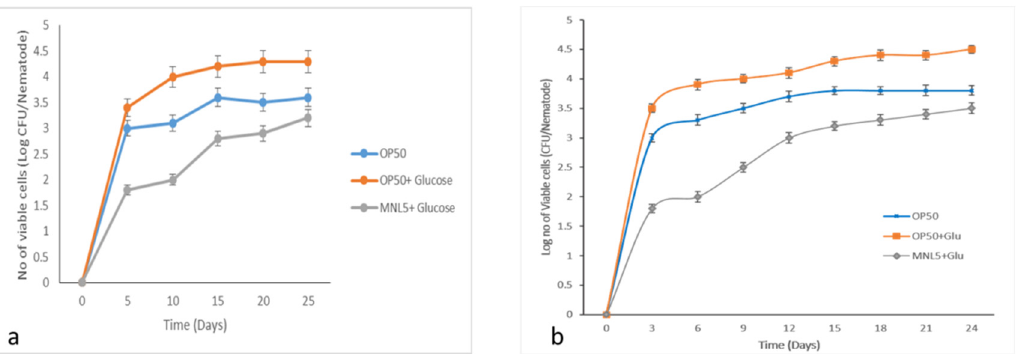
Figure 4. Bacterial colonization in C. elegans . ( a ) DAF-2, ( b ) LIU1 model; the treatments such as, OP50 (Control), MNL+ GLU ( P. acidilactici MNL5 with Glucose) [Treatment]), OP50+GLU ( E. coli OP50 with Glucose [Positive Control]; Evaluation of MNL5 colonization (numbers of log CFU/nematode) in the nematode intestine. In each experiment, 100 worms were administered, repeated twice and plotted using OASIS II. All results are presented as the means ± standard error mean.